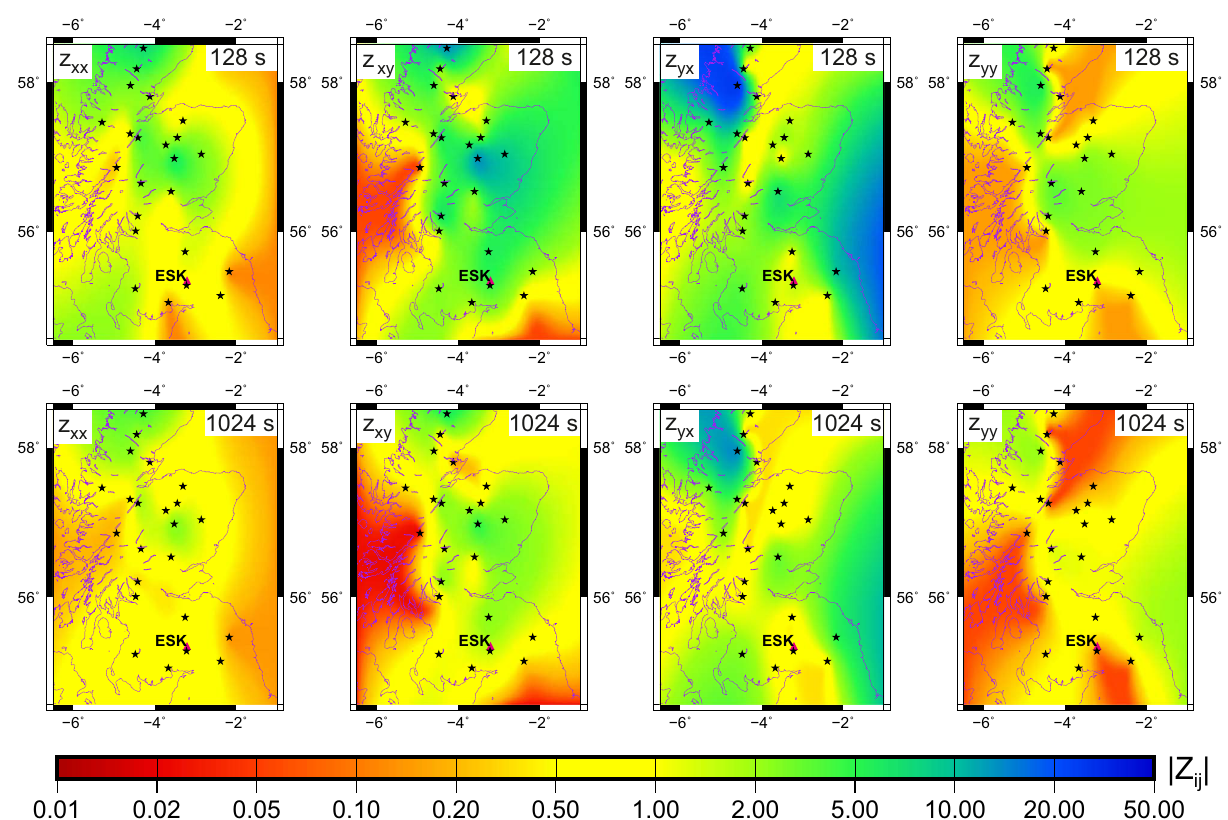
Fig. 3. Impedance tensor components, Z ij , at periods of 128 s and 1024 s interpolated using bicubic splines (Smith & Wessel, 1990). Stars indicate site